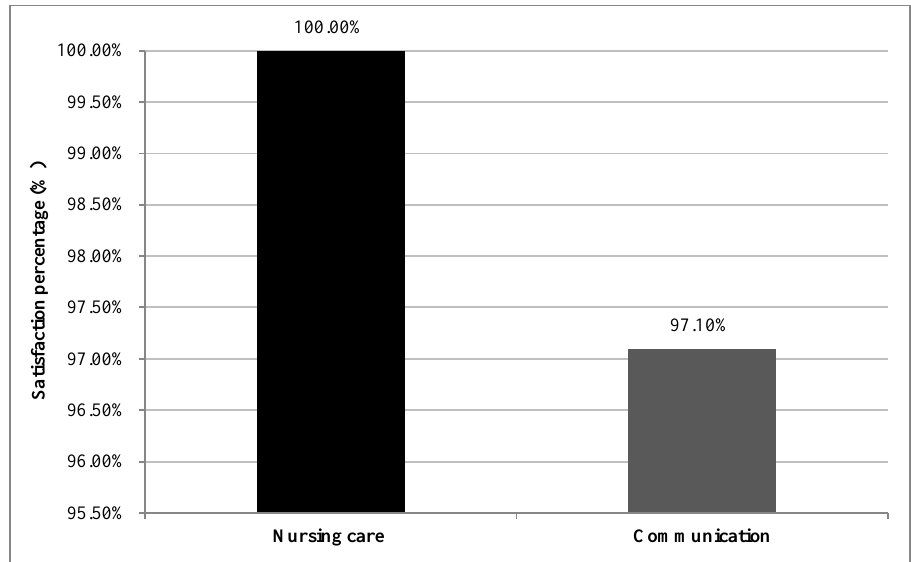
Figure 3. Satisfaction by the Nursing staff